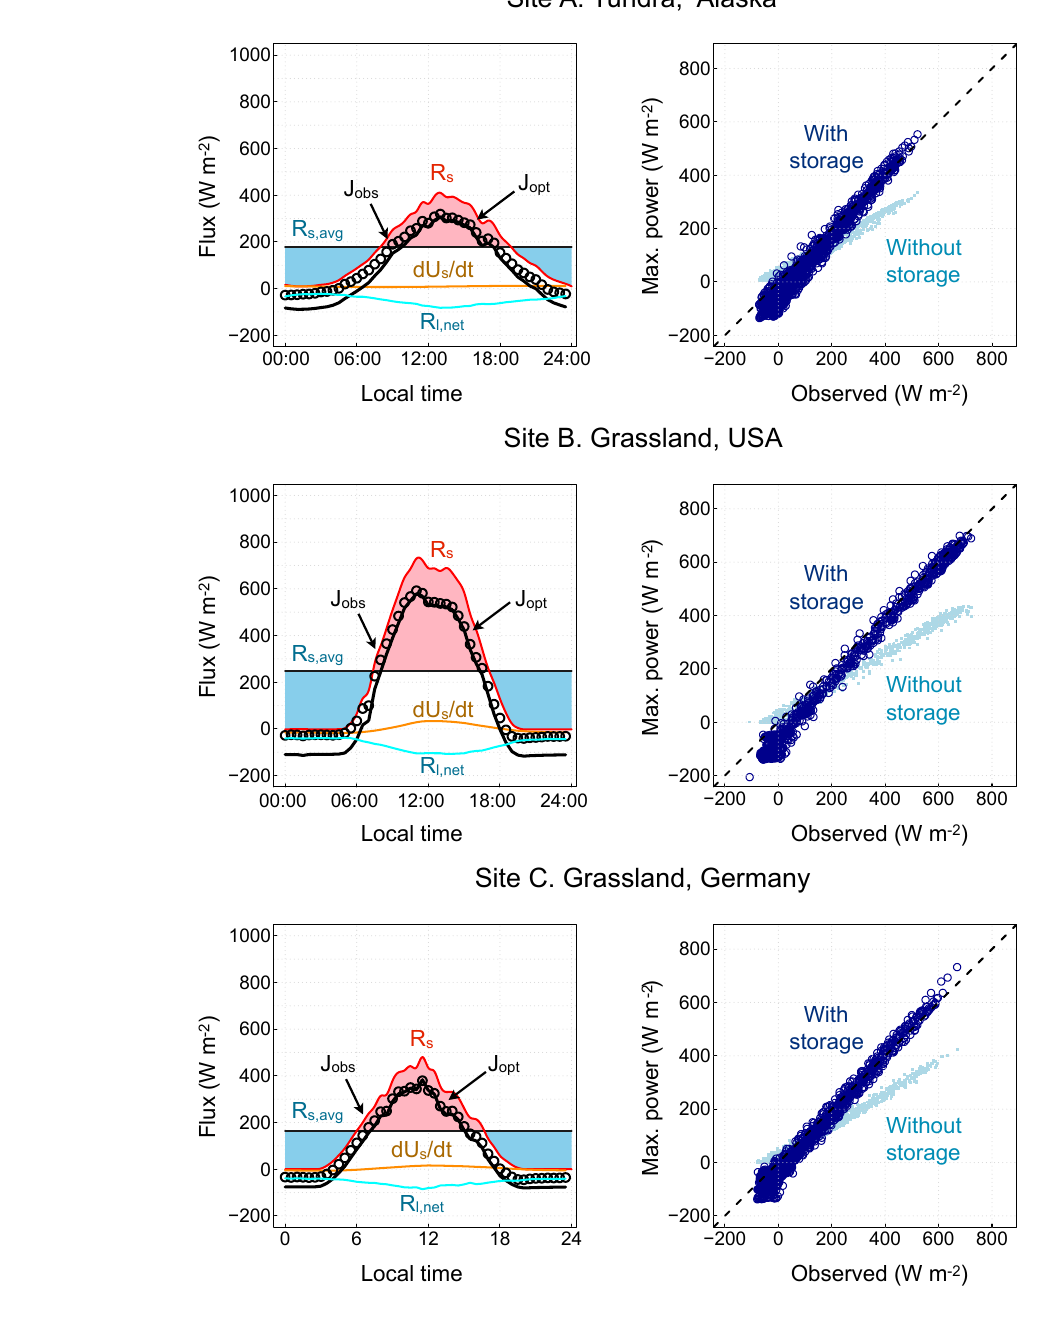
is found across the range of climatological settings shown in Fig. 3. Also note that the maximum power limit without an explicit consideration of heat storage changes (i.e., with d U s / d t = 0 and d U a / d t = 0 in Eq. (7), as in Kleidon et al., 2014, and as indicated by light blue points in Fig. 3)